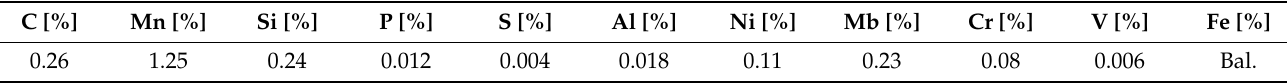
Table 2. Chemical composition (wt. %.) of L80-1 steel, norm ISO 11960 API